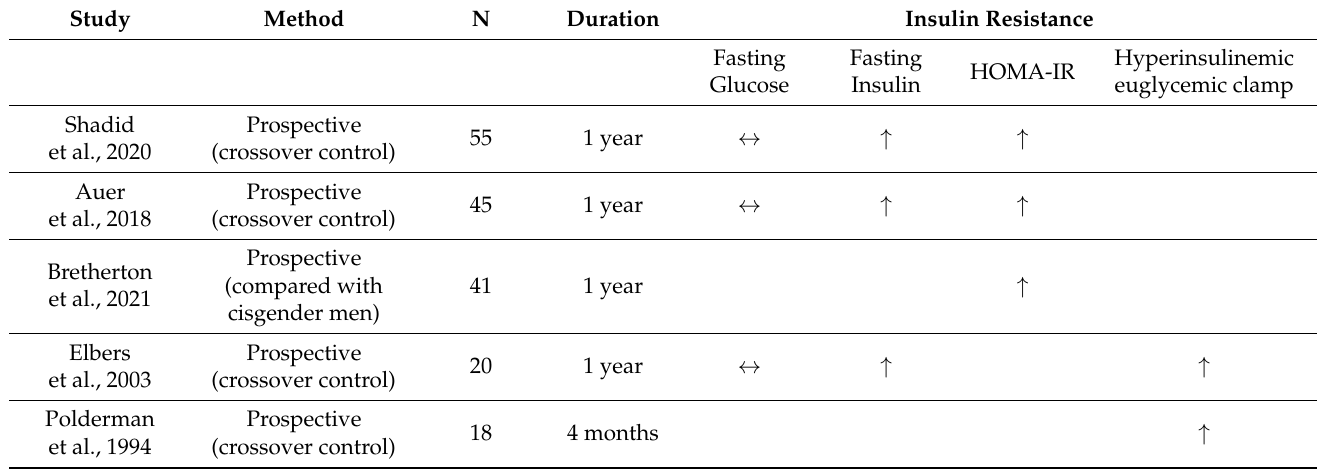
Table 2. Studies investigating insulin resistance in transgender